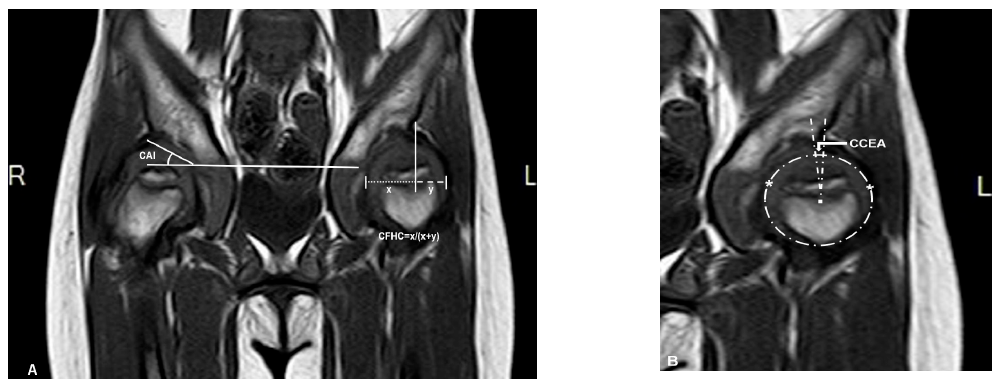
Figure 2. Magnetic resonance imaging (MRI) (coronal T1 sequence) scan of the same patient (patient 3). ( A ) Right hip measurement of the cartilaginous acetabular index (CAI), left hip measurement of cartilaginous femoral head coverage (CFHC): ‘x’ is the distance between cartilaginous lateral margin of acetabulum and medial margin of femoral head; ‘y’ is the distance between cartilaginous lateral margin of acetabulum and lateral margin of femoral head. ( B ) Using the method of Siddesh to measure the cartilaginous center-edge angle (CCEA) of the left hip, ‘*’ is the reference points which are marked on the medial and lateral limits of the growth plate. A circle is marked connecting both the reference points ensuring that the circle just touches the inner margin of the epiphysis but does not extend outside the femoral head